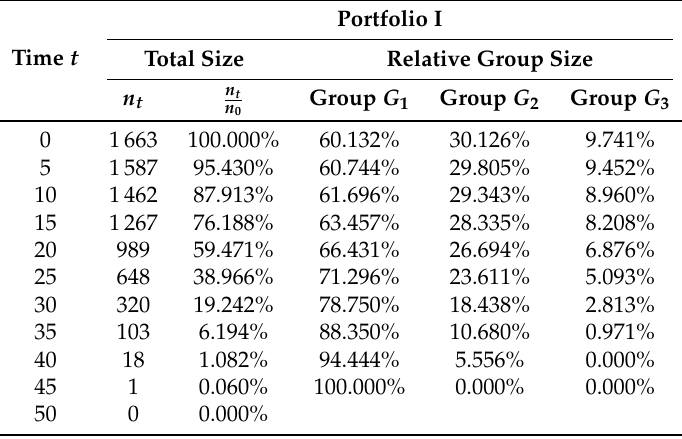
Table 21. Portfolio I: portfolio size and composition.